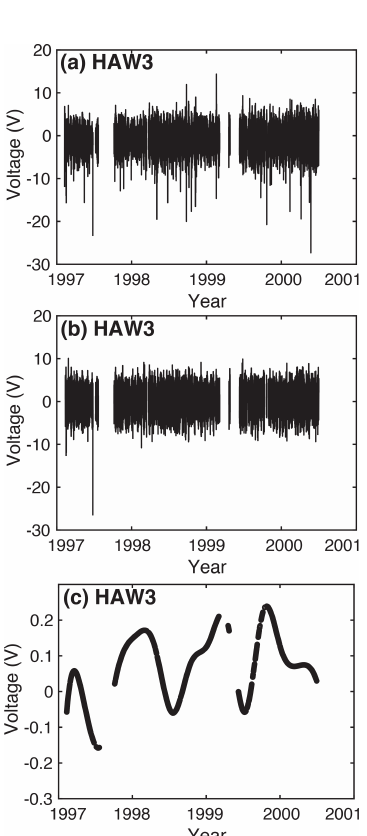
Figure 2. Each step of the data processing is shown here using HAW3 as an example: (a) the raw time series, (b) the time se- ries with days of Ap > 20 removed and tidal signals also removed, and (c) the smoothed time series produced by splines with 90d